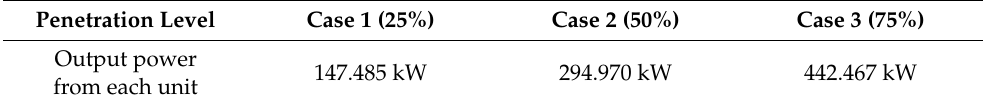
Table 1. Renewable energy sources (RES) planning for different penetration